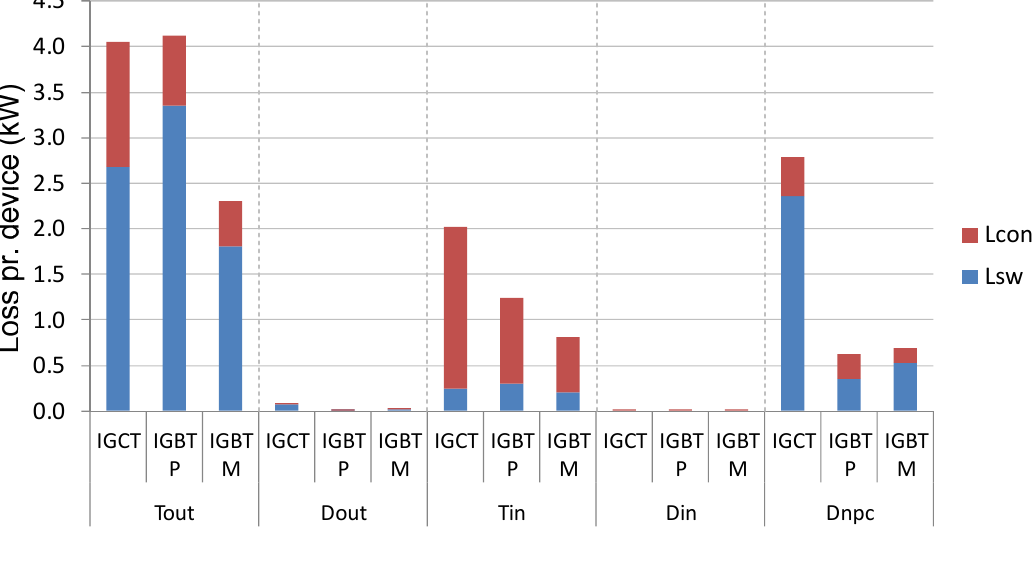
means switching loss-blue). sw